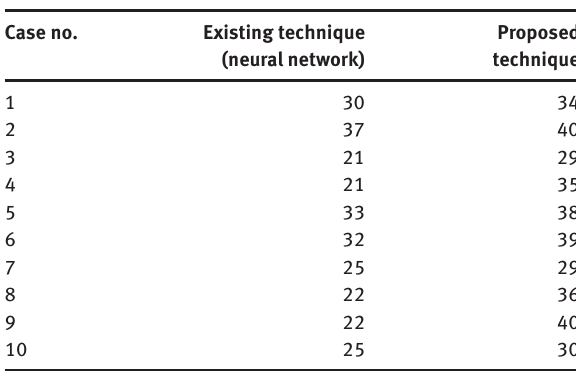
Table 1: Tabulation for